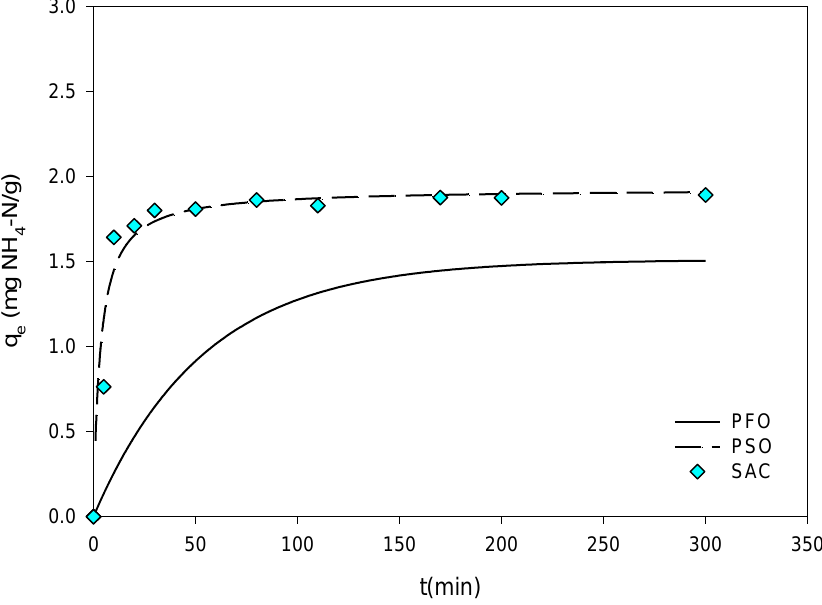
Figure 2. Pseudo-first- and pseudo-second-order kinetics of AnMBR permeate with Purolite SSTC60.